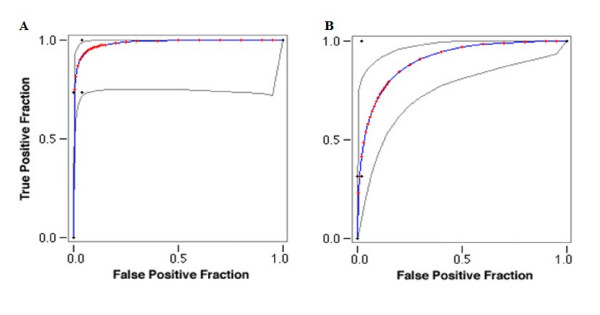
Rank ROC curve obtained for disease validation. (A) Weight value method. (B) HWEc method. Red symbols and Blue line: Fitted ROC curve. Gray lines: 95% confidence interval of the fitted ROC curve.